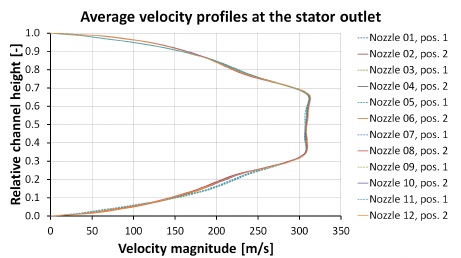
Figure 8. Velocity profiles at the stator